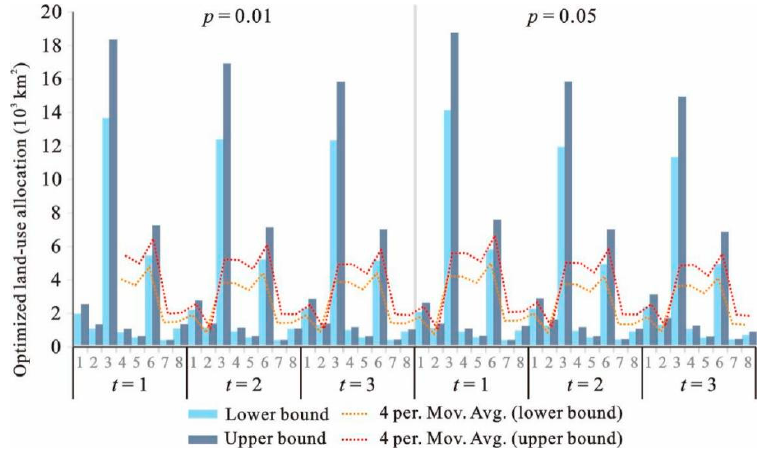
Figure 3. Optimized land-use allocation under p of 0.01 and 0.05 ( k = 1).